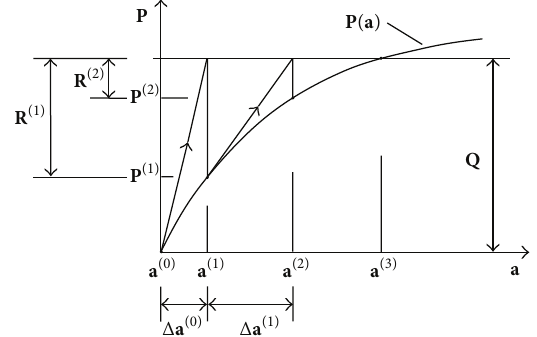
Figure 1: Convergence of the Newton-Raphson iteration